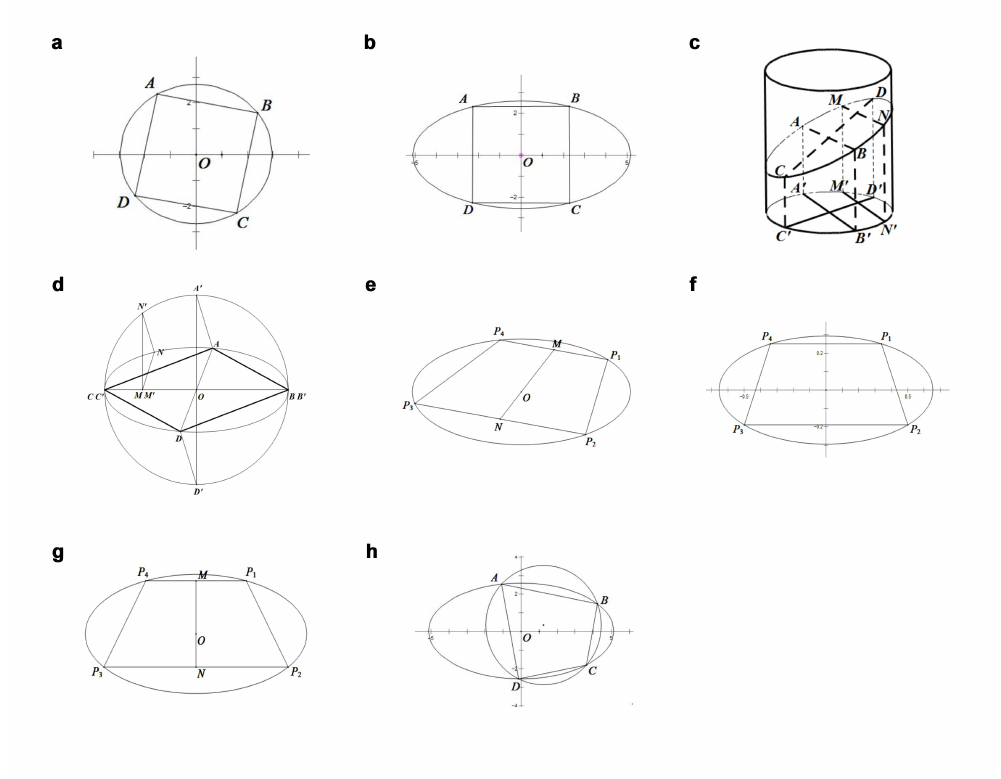
Figure 5: The minimal area of circumscribed ellipses. (a) The axes of the circumscribed ellipses are not parallel to the square’s sides. (b) The axes of the circumscribed ellipses are parallel to the square’s sides. (c) If the projections of an ellipse’s two di- ameters on its bottom are perpendicular, these two diameters must be conjugate. (d) The drawing method of the minimal cir- cumscribed ellipse of a parallelogram. (e) The minimal circumscribed ellipse of a trapezium. (f) Set up a rectangular coordinate system for an isosceles trapezium. (g) The minimal circumscribed ellipse of an isosceles trapezium. (h) Set up a rectangular coordinate system for a cyclic